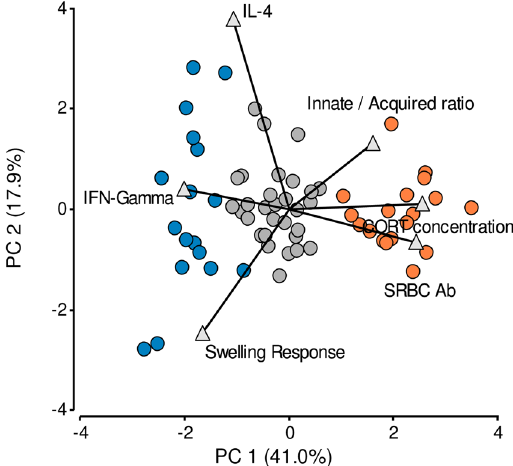
Figure 6. Exploration of data variability and clustering procedure post- chronic social stress. Principal component analysis bi-plot graph. Each bird is represented by a dot and each explanatory and clustering variable used in the analysis is represented by triangle. Total distribution of the data categorized according to the birds’ INP after stress disruption. Full blue dots and full orange dots represent extreme LEWIS- and FISCHER- like birds respectively; full grey dots represent birds with intermediate configuration. The eigenvalues are shown in brackets next to each component. Number of birds in the study: 65. Number of birds per group: LEWIS- Like = 17, FISCHER-Like = 18, Intermediate = 30.